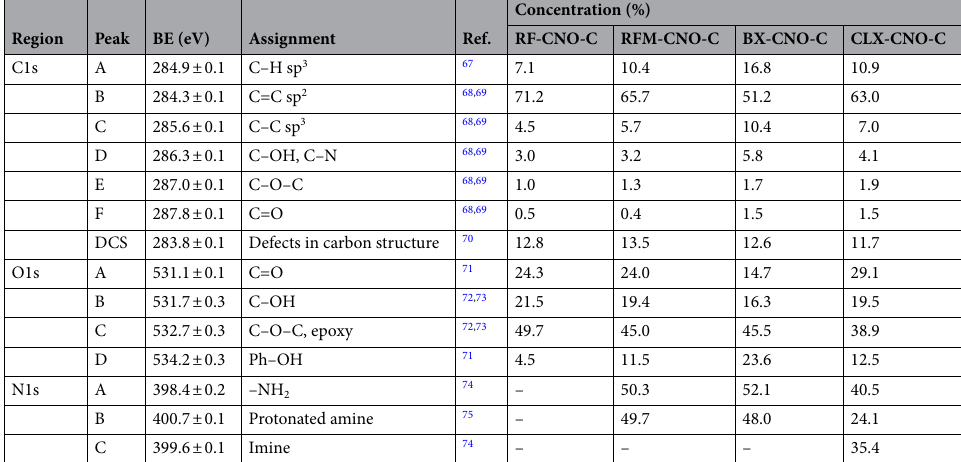
Table 2. Distribution of elements obtained from the deconvolution of the C1s, O1s, and N1s spectra by XPS.